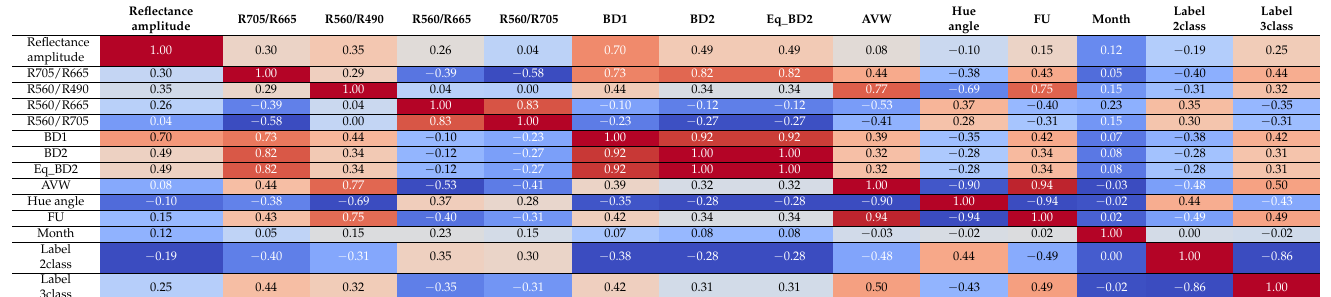
Table 6. Correlation coefficients between the features and the features and target labels. The blue colours indicate negative correlation while orange/red colours indicate positive correlations. The correlations higher than 0.08 and lower than − 0.08 were statistically significant ( p value = 0.05).